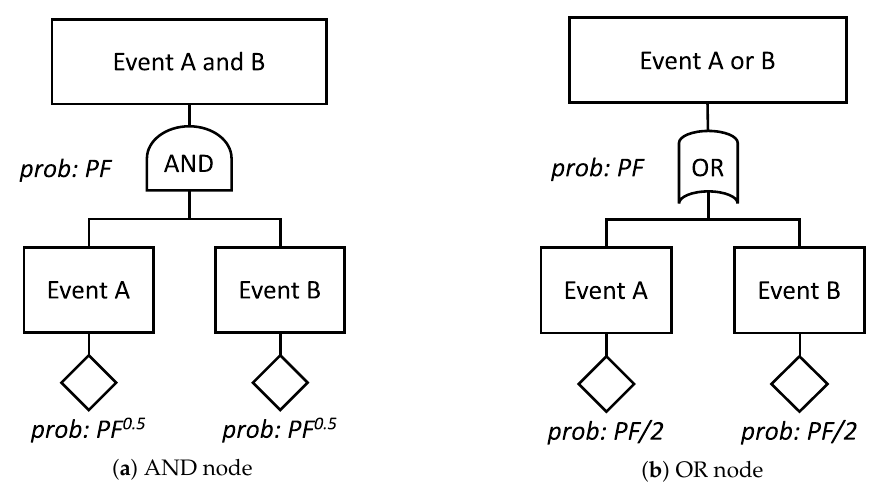
Figure 1. Rationale of the failure rate calculation for the “top-down”